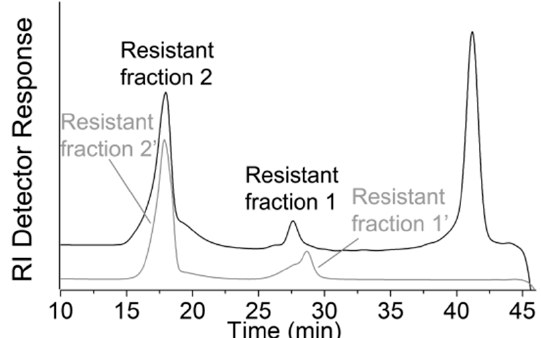
Figure 1. Black line: high-performance gel permeation chromatography (HPGPC) profiles of fully digested heparosan by heparin lyase III. Most of the disaccharides and digestion buffer salts have been removed by 1 kDa molecular weight cut-off (MWCO) spin column. Gray line: HPGPC profiles of heparin lyase III fully digested resistant fraction 2 after treatment with phospholipase A1 and A2. All of the disaccharides and digestion buffer salt have been removed by 1 kDa MWCO spin column.